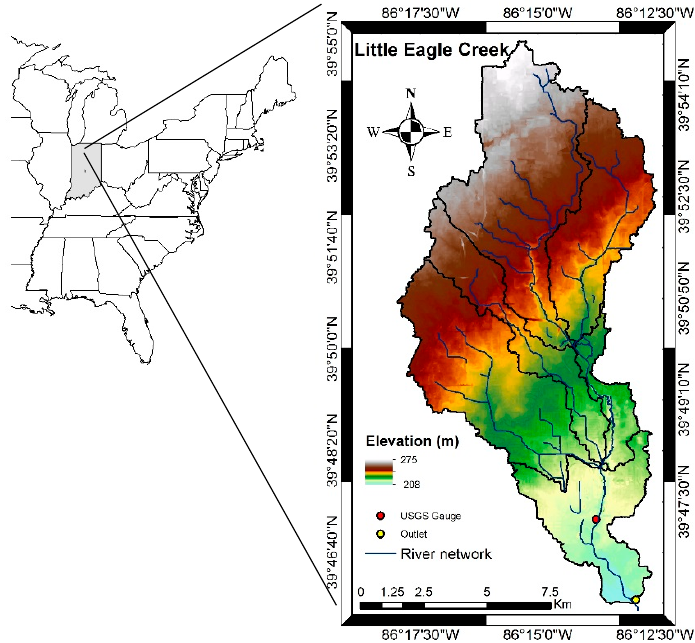
Figure 1. Index map showing location of the Little Eagle Creek (LEC) watershed in Indiana.